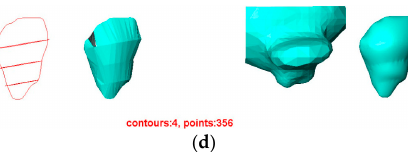
Figure 12. Surface reconstruction of a hepatic tumor by four methods. The numbers of contours are the same in different rows, but the contours were drawn by different users: ( a ) User 1; ( b ) User 2; ( c ) User 3; ( d ) User 4. For each row, from left to right: the contours used, the surface reconstructed by BPA, the surface reconstructed by Power Crust, the surface reconstructed by Poisson, and the surface reconstructed by VSR.